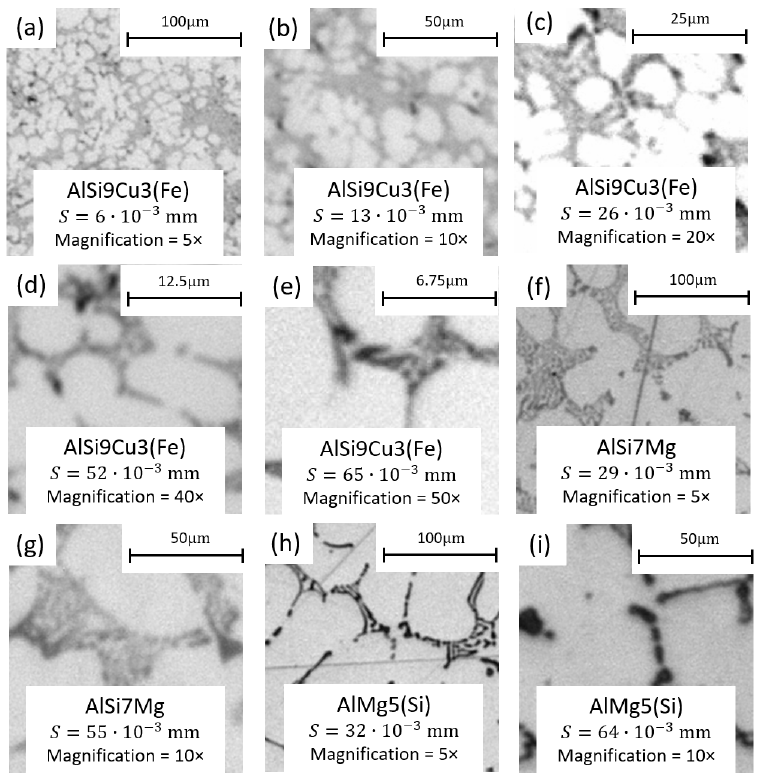
Figure 2. The procedure of deriving different S values using different magnifications on the mi-